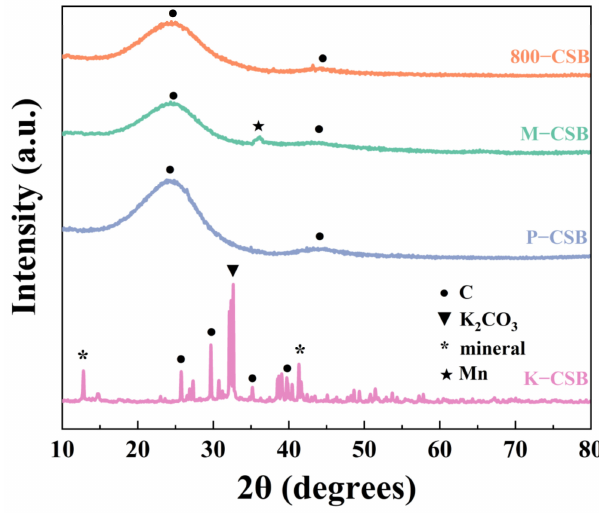
Figure 3. XRD pattern of modified